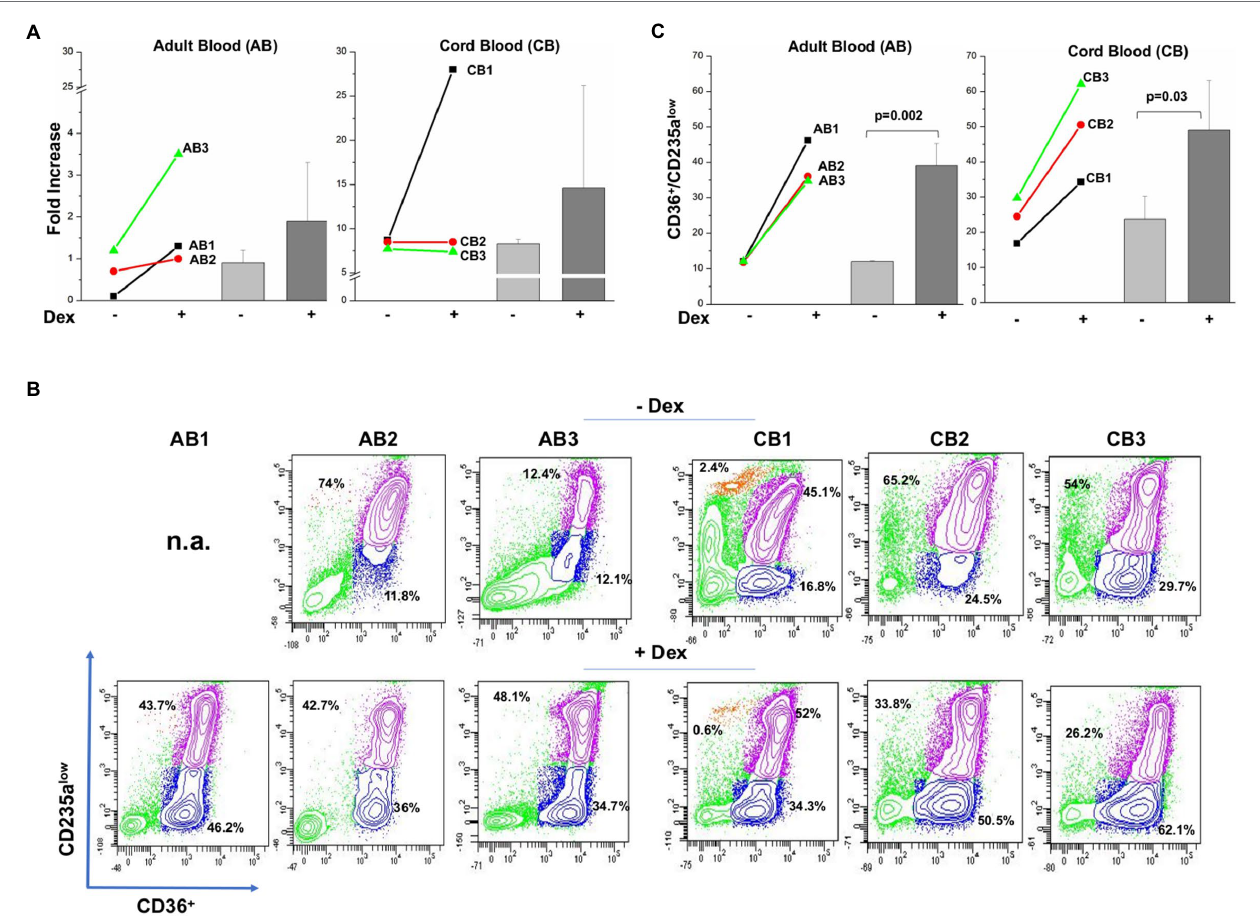
FIGURE 1 | Both adult blood and cord blood generate by day 10, a greater proportion of immature erythroid cells in cultures with Dex than in those without Dex. (A) Fold increase of erythroid cells generated by day 10 in cultures of three separate adult blood (AB1, AB2, and AB3) and cord blood (CB1, CB2, and CB3) with and without Dex. Values are presented as individual values for each donor and as Mean (±SD). (B) Flow cytometry analyses for CD63 and CD235a of the cells present at day 10 in the cultures presented in (A) . These cells were subjected to the phosphoproteomic analyses presented in Figure 2 . CD36/CD235a expression classifies the cultured cells into immature (blue contour) and matures (purple contour) erythroblasts (Falchi et al., 2015; Federici et al., 2019). The frequency of the immature and mature cells obtained from each source is indicated within the quadrant. The profile of the cells obtained with Dex has been already reported (Federici et al., 2019). (C) Frequency of immature erythroid cells (blue gate in B ) present at day 10 in culture of adult blood and cord blood stimulated with and without Dex. Values are presented as individual values for each donor and as Mean (±SD). Statistical analysis was performed by paired t